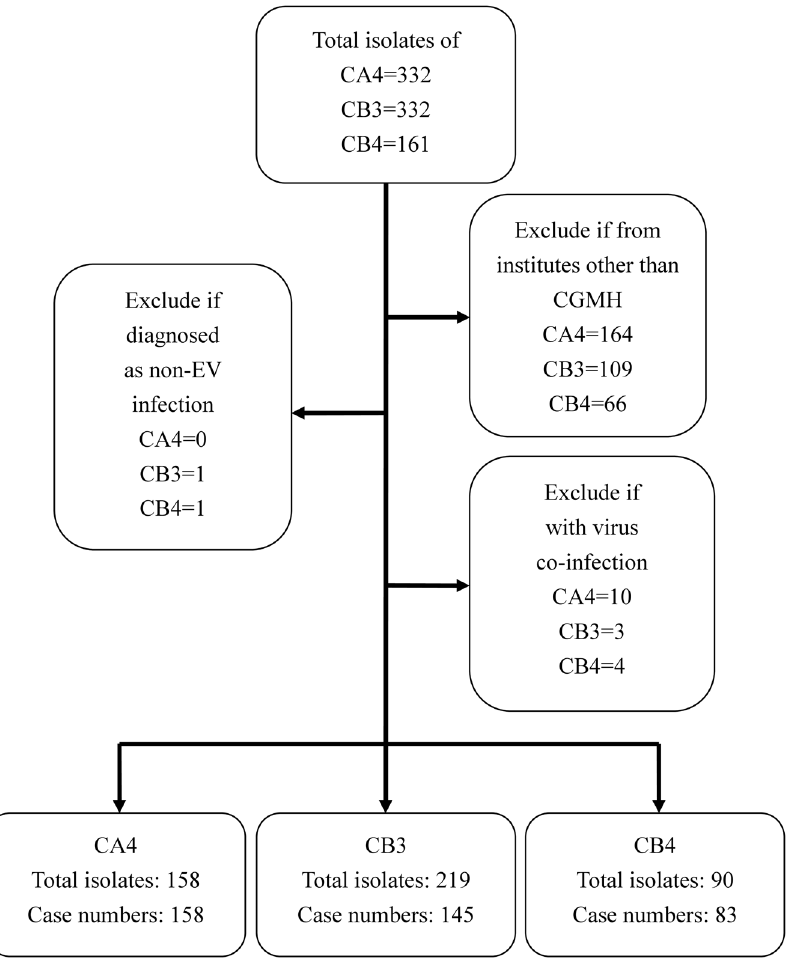
Figure 1. Flow chart of the patients enrolled in this study. CA4, coxsackievirus A4; CB3, coxsackievirus B3; CB4, coxsackievirus B4.